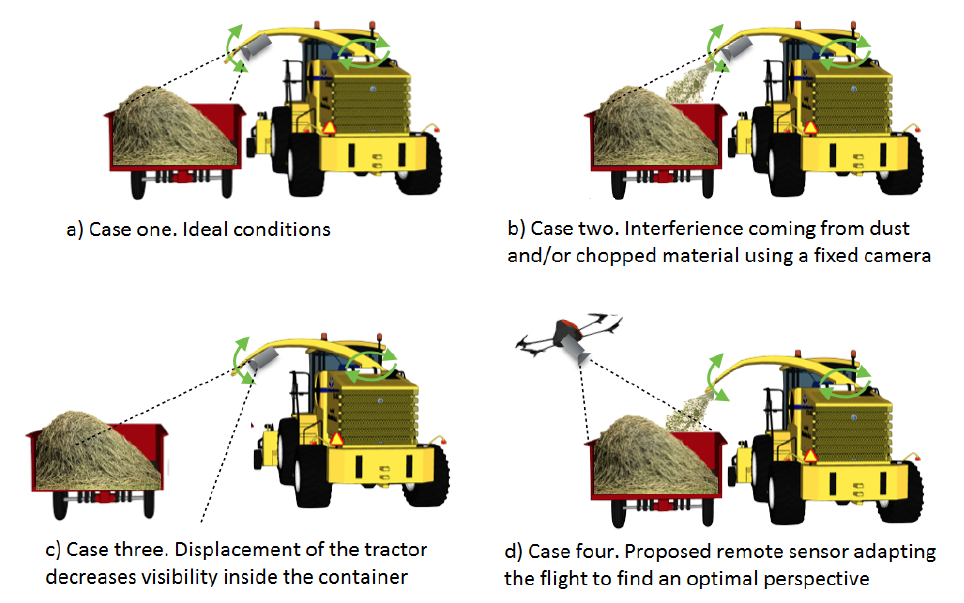
Figure 11. Possible limitations when using a fixed sensor and advantages of using a smart flying sensor for a loading application during forage